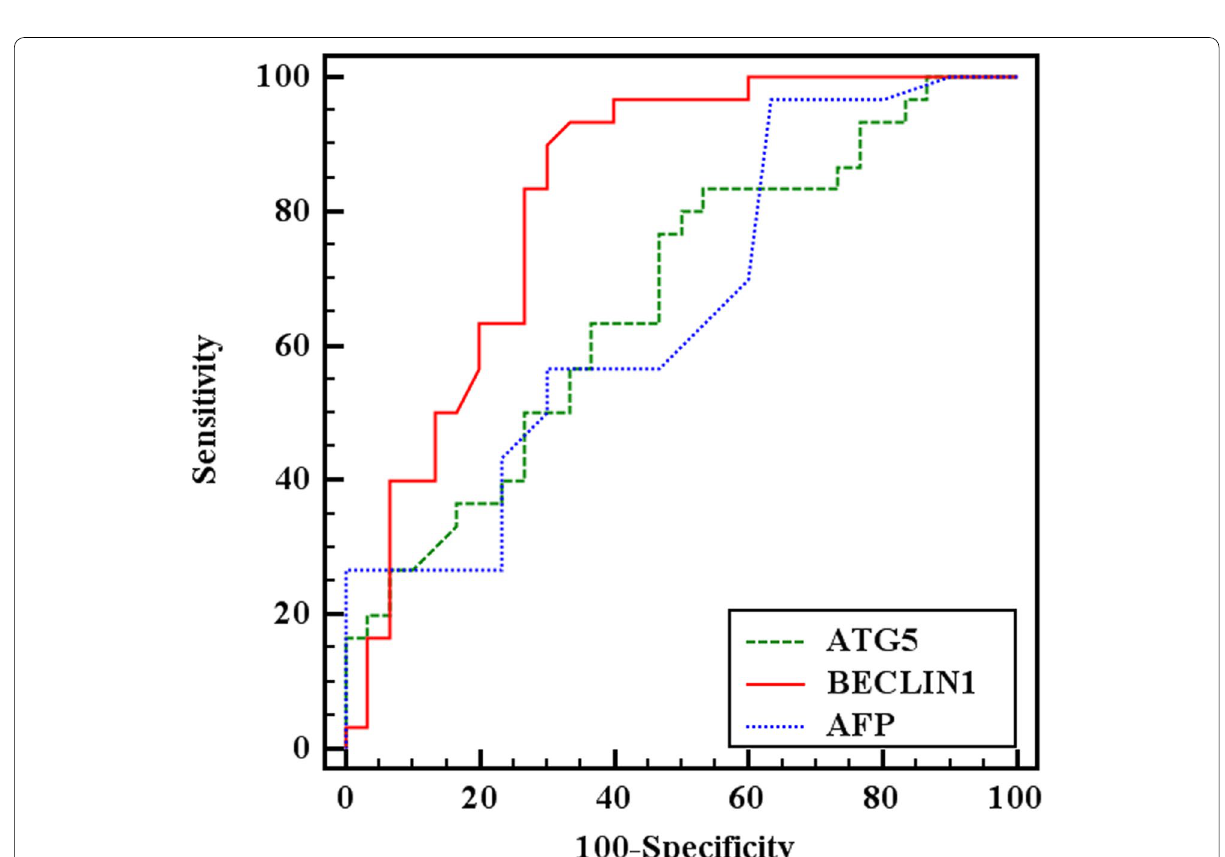
Fig. 1 ROC curve for AFP, ATG5, and BECLIN1 to diagnose HCC patients from cirrhotic